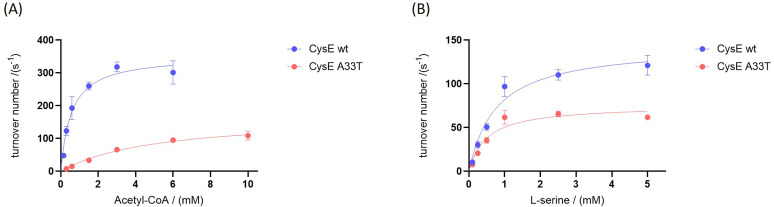
Kinetic characterization of CysE variants.(A) Michaelis-Menten plots of CysE variants as a function of acetyl-CoA concentration at a saturating L-serine concentration of 20 mM and (B) Michaelis-Menten plots of CysE variants as a function of serine concentration at a non-saturating acetyl-CoA concentration of 0.6 mM. All points were measured in triplicate, showing the mean and standard deviation.